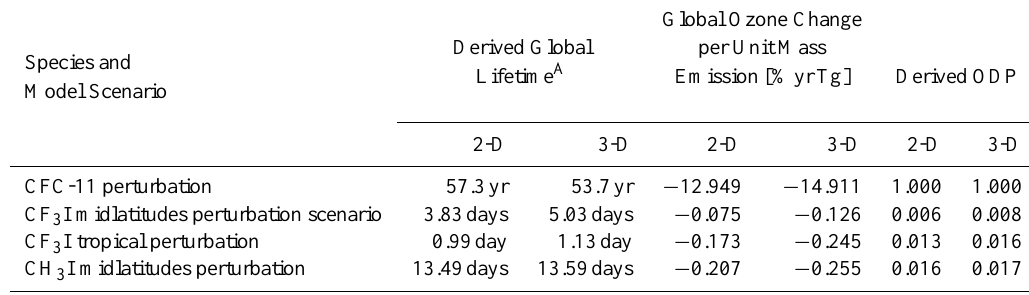
Table 2. Derived ODP values of CF 3 I for mid-latitudes and tropics emission scenarios and CH 3 I for mid-latitudes emission scenarios using the UIUC 2-D and the MOZART-3 3-D